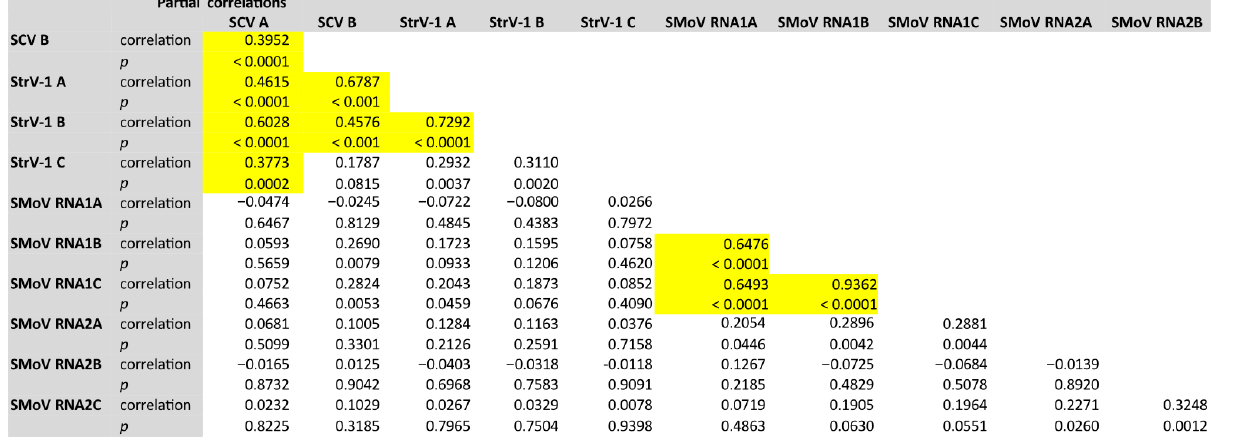
Figure 6. Results of testing of F. vesca plants 30 dpi following single aphid transmission with an inoculation access period of 24 h. Black rectangles indicate positive detection.